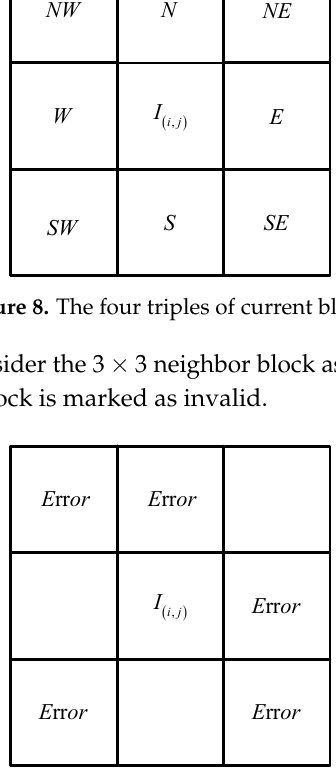
Figure 9. The 3 × 3 block-neighborhood of current